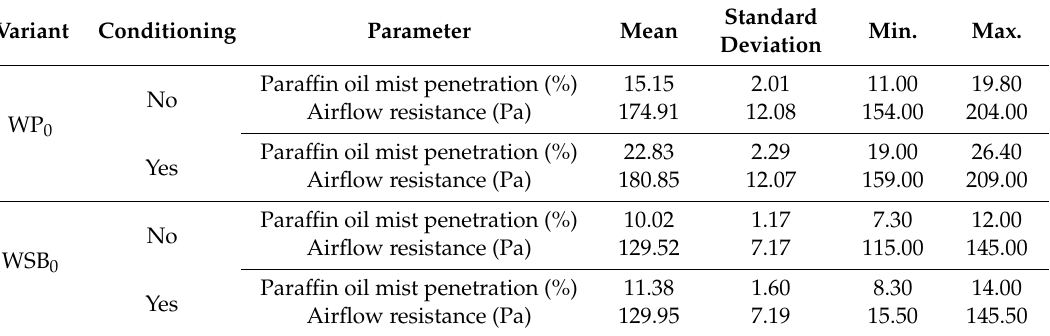
Table 1. Characteristics of the produced filtering nonwovens: WP 0 was based on polypropylene and WSB 0 was based on PET-doped polypropylene.